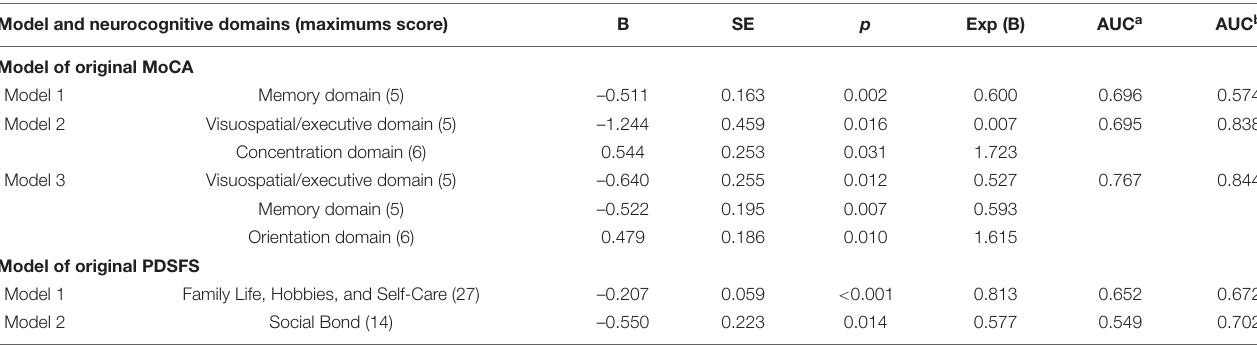
TABLE 8 | The best predictive model of the MoCA and the PDSFS for PD-MCI and PDD by using the logistic regression with the backward stepwise. Model and neurocognitive domains (maximums score)